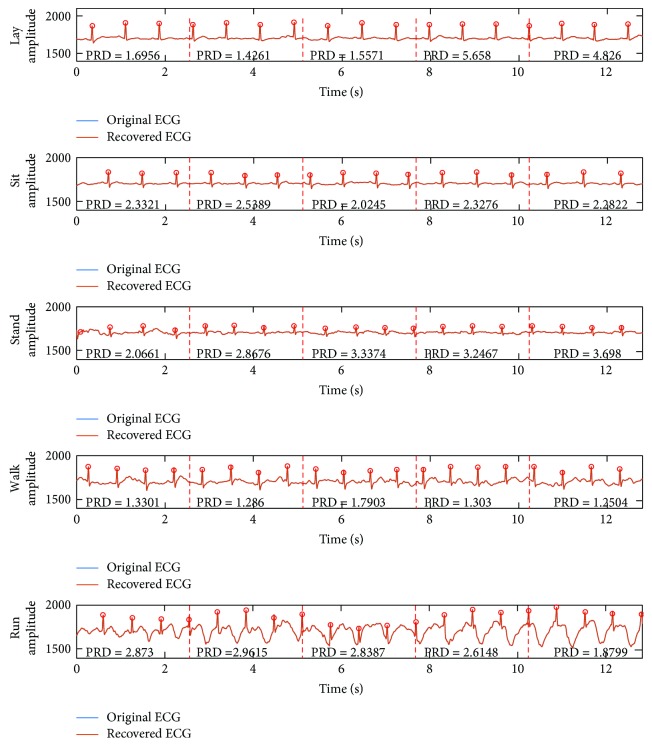
The visual inspection results. The recovery algorithm and sparse bases are BSBL and DCT, respectively: N = 512, M = 256, and K = 4; Pan-Tompkins method [30] was used for R-peak detection in the recovery signals. The red dotted lines are the segmented indicators of every frame, and the signal quality of each recovered frame was evaluated by PRD.